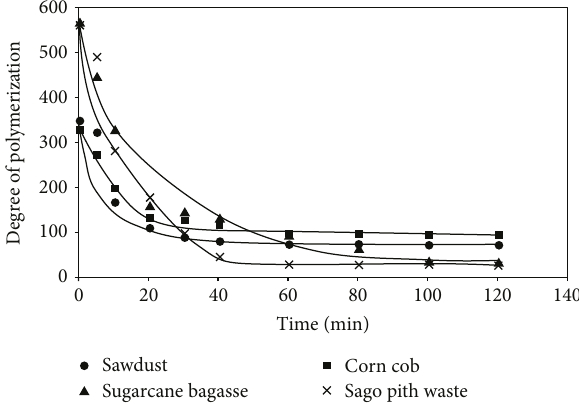
Figure 3: Degree of polymerization (DPw) of cello-oligomers derived from cellulose fi bres of various lignocellulosic biomass at di ff erent reaction times: ( ● ) sawdust ( DPw = 351 ), ( bagasse ( DPw = 571 ), ( ■ ) corn cob ( DPw = 329 ), and ( x ) sago pith wastes ( DPw = 564 ). Parentheses show the initial DPw values of lignocellulosic biomass